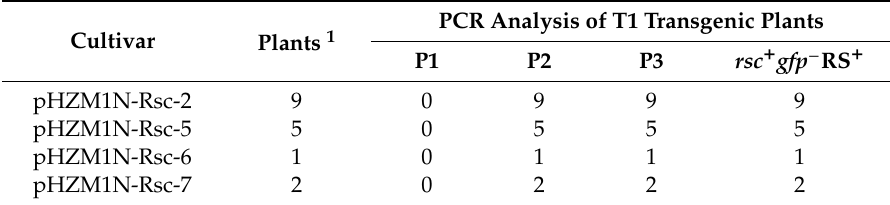
Table 3. PCR analysis of T 1 transgenic maize plants.